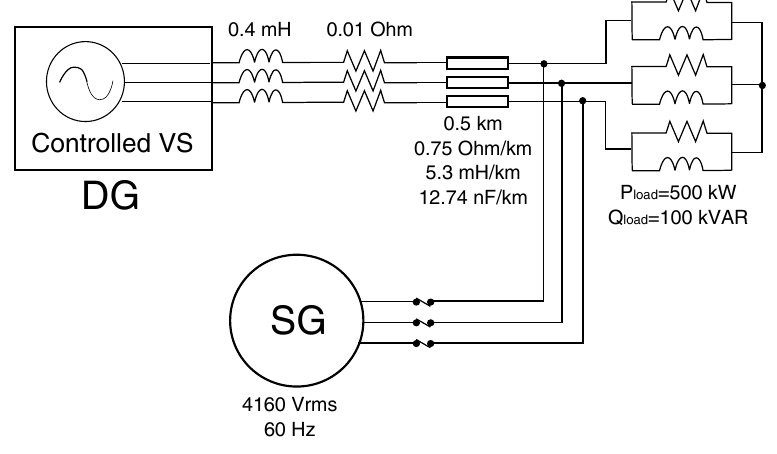
Figure 7. Simulation